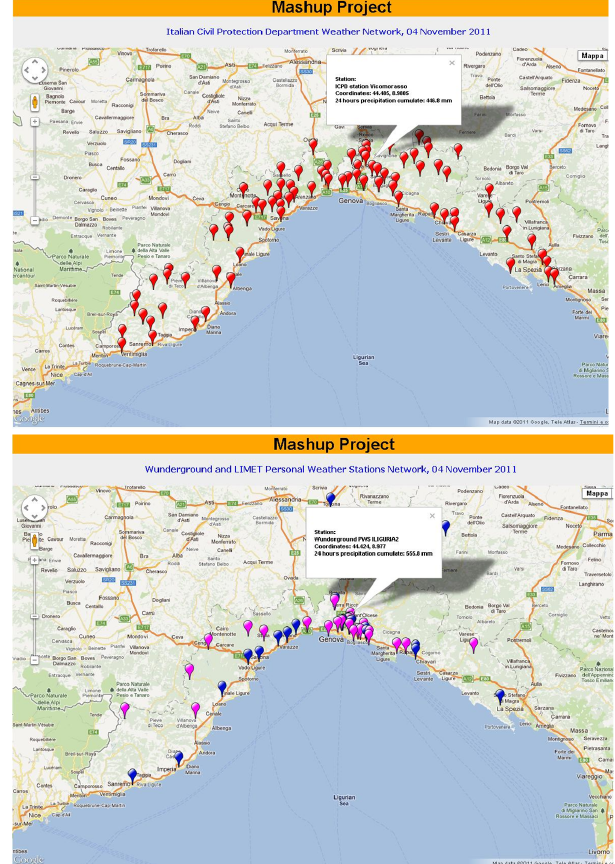
Fig. 2. An example of mapping of official ICPD weather stations (red markers) and PWS from Weather Underground (blue markers) and LIMET (purple markers) networks on the Google